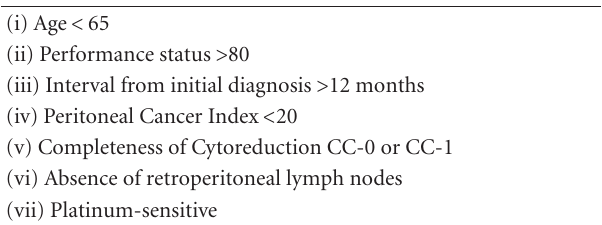
Table 4: Prognostic-predictive factor for “optimal” HIPEC in recurrent